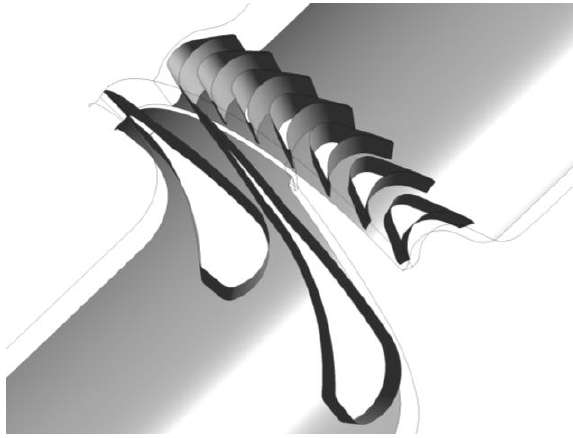
Fig. 2. Velocity triangle of the designed ORC impulse stage. Fig. 3. Computatiomal model of the element of the single stage axial impulse